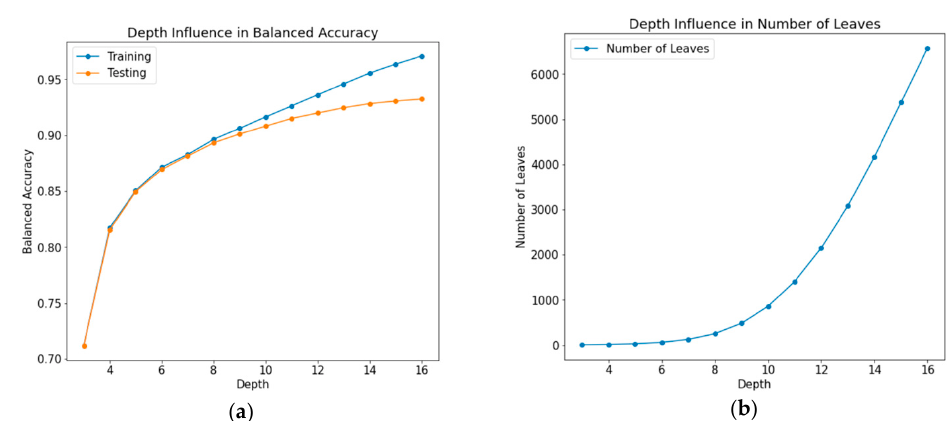
Figure 2. Model’s performance as function of depth: ( a ) tree depth influence in balanced accuracy, and ( b ) tree depth influence in number of leaves.